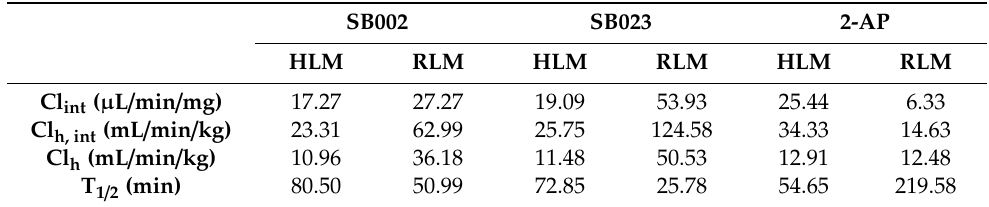
Table 4. Calculated in vitro and predicted in vivo clearance parameters of SB002, SB023, and 2-AP from human (HLM) and rat (RLM) liver